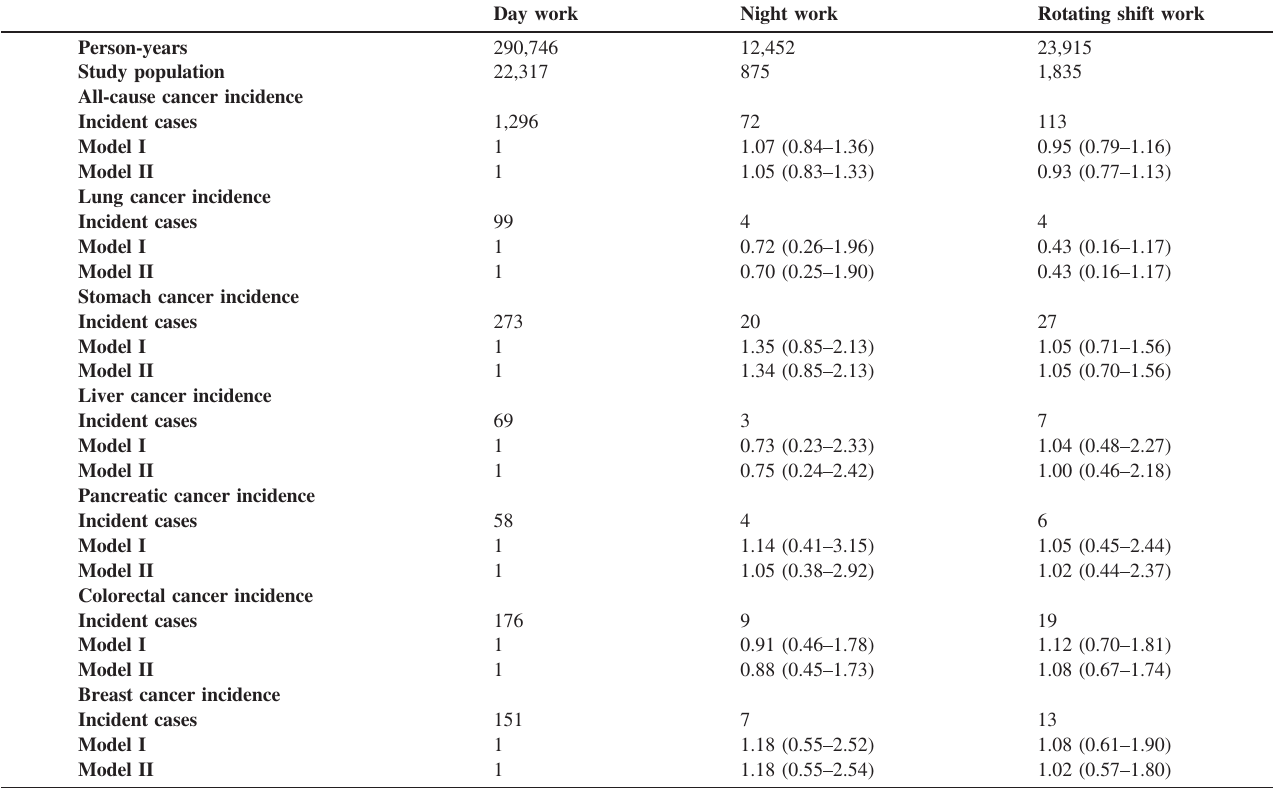
Table 3. Association of night work and rotating shift work with cancer incidence among Japanese women (JACC Study) Day work Night work Rotating shift